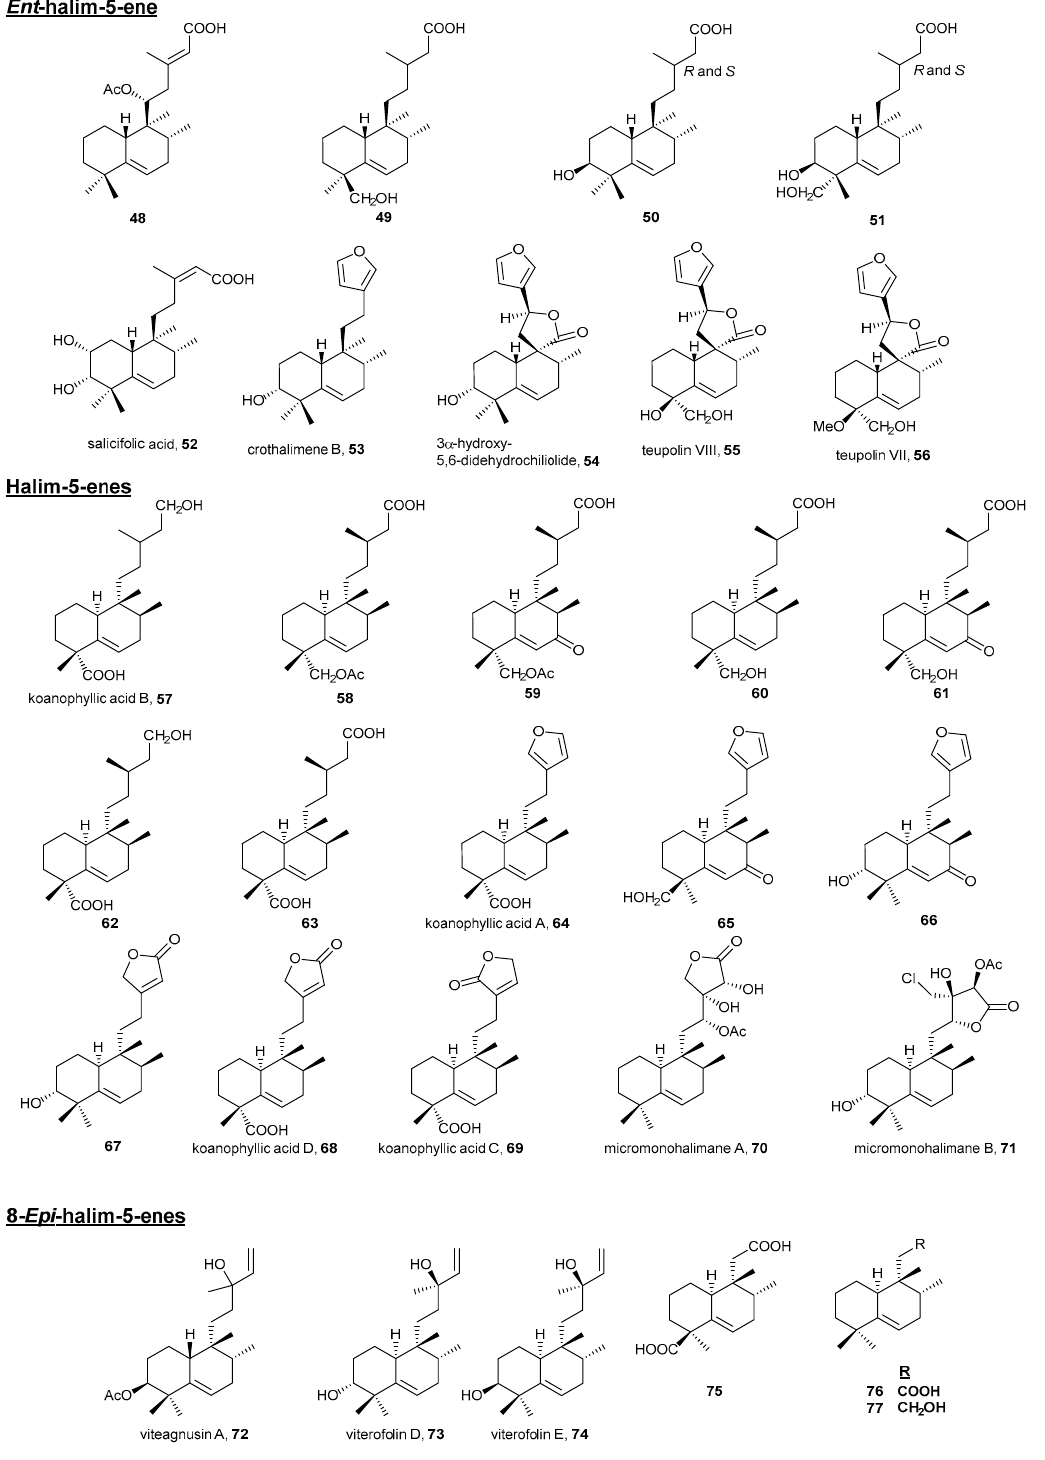
Figure 3. Halimane diterpenoids with the annular double bond in Ring B.